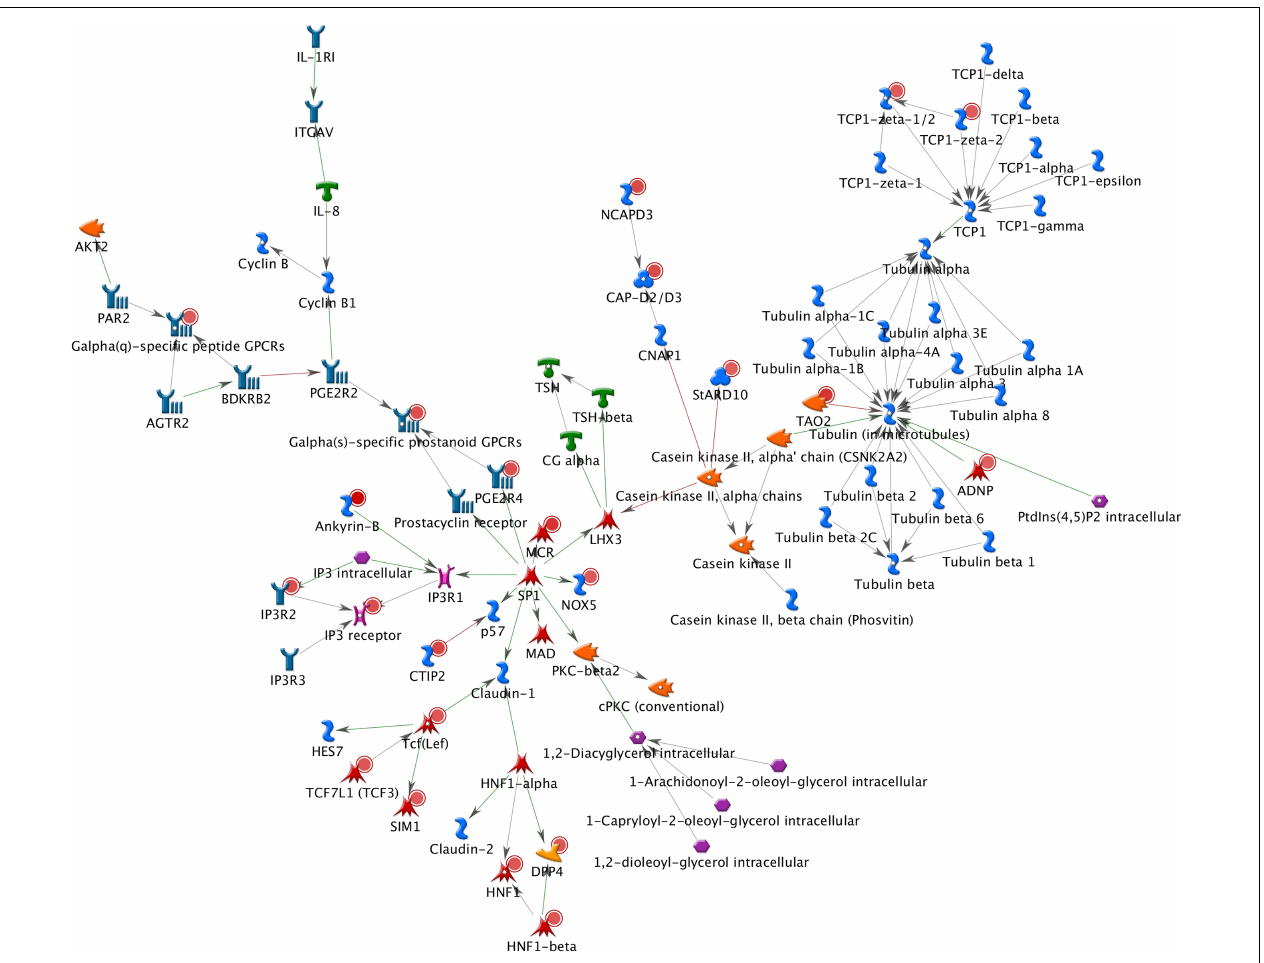
FIGURE 3 | The top one functional subnetwork. This subnetwork was saturated with 22 objects and 39 interactions, with a hub in transcription factor SP1 with 10 activation interactions. Thick cyan lines indicate the fragments of canonical pathways. Upregulated genes are marked with red circles and downregulated with blue circles. Green and red arrows indicate activation and inhibition effect,